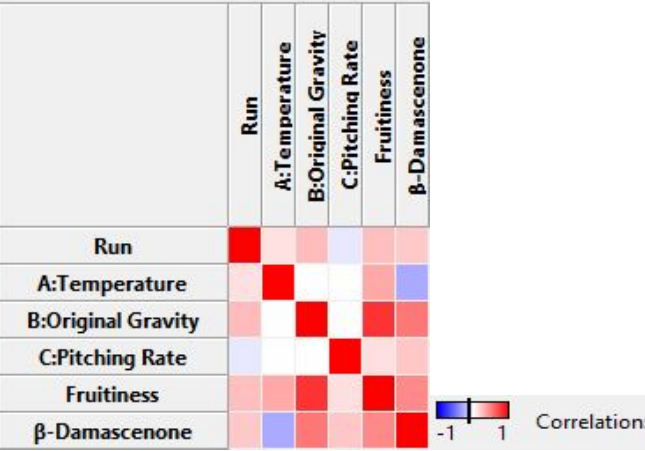
Figure 4. Visualization of Pearson’s correlation of selected responses (fruitiness and ( E )- β -damascenone) and factors A, Temperature; B, Original Gravity; and C, Pitching Rate of the response surface methodology (RSM) for the determination of linear correlations between two variables where 1 stands for a strong positive correlation, 0 for no correlation, and − 1 for a strong negative correlation.